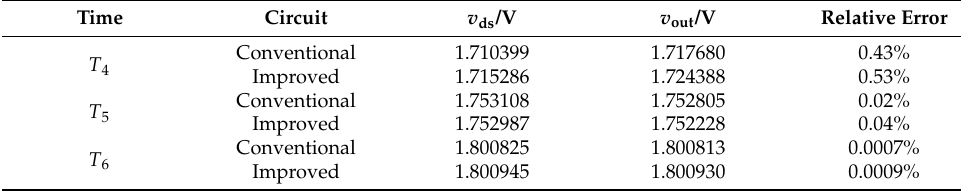
Table 4. Comparison of v ds and v out during the on-steady state.